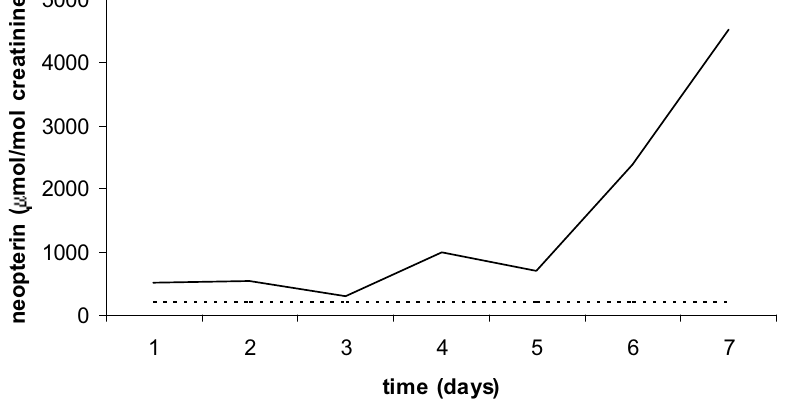
Figure 4. A 69-year-old woman with history of breast carcinoma and second recurrence of EOC was treated with the combination of paclitaxel (175 mg/m 2 ) and carboplatin (area under the curve 6). On day 5 the patient com- plained about fever and weakness, and therapy with oral ofloxacin was started. Two days later she came for a schedule visit complaining about the deterioration of general status, anuria and anorexia. A marked rise of serum creatinine was detected (from 90 to 382 µ mol/l). The patient was admitted and transiently improved after infu- sion therapy. However, on day 9 sepsis with hypotension and multiple organ failure was evident, and the patient died despite intensive therapy on day 12. A marked increase in urinary neopterin was observed after the admin- istration of therapy, preceding the manifestation of the fatal complication. The upper limit of normal urinary neopterin concentrations is indicated by dashed line.